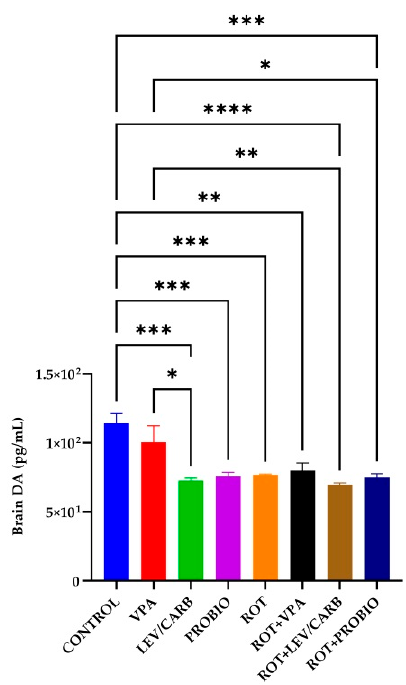
Figure 8. Brain DA level in the studied Danio rerio ( n = 5) groups (*— p < 0.05; **— p < 0.005; ***— p <